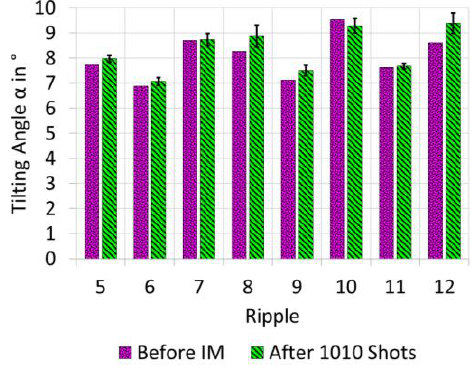
Figure 12. Tilting angle measured on mortar insert before injection moulding and after 1010 injec- tion-moulded parts. The 95% confidence interval for repeatability of measurement is indicated in- dividually by a black line for each ripple.